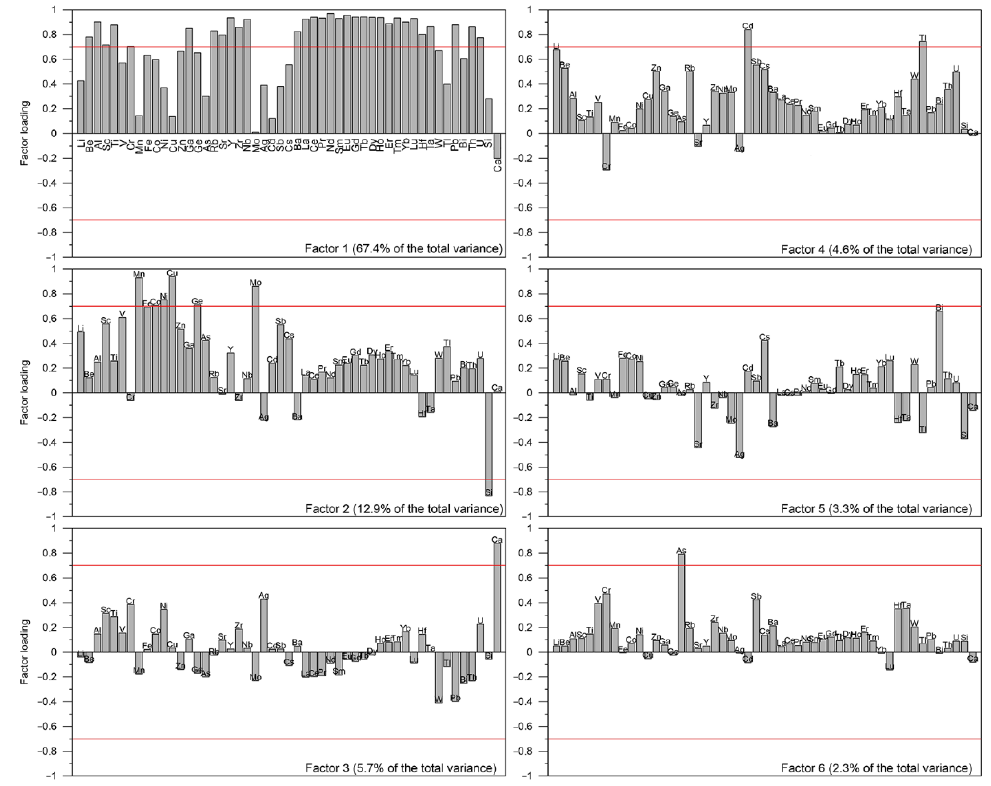
Figure 2. Distribution of factor loadings of principle component analysis (PCA) affecting the chemical elements composition of the Arctic Seas bottom sediments for six factors. Statistically significant factor loadings are highlighted in red line (higher than 0.7).